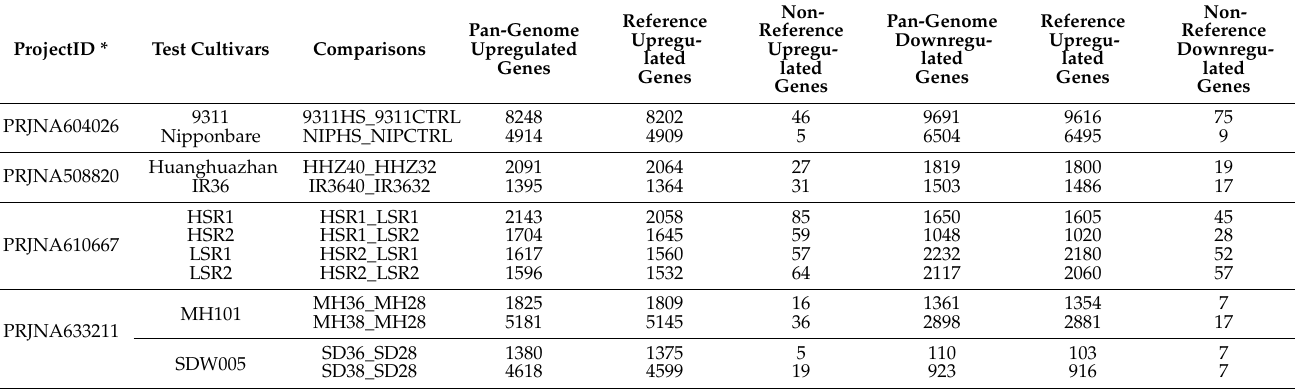
Table 3. Numbers of DEGs in the 4 RNA-seq datasets of rice under heat